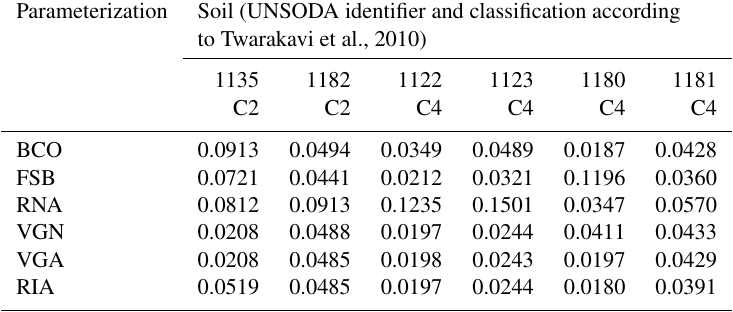
Table C8. Root mean square errors of the parameter fits for the clayey